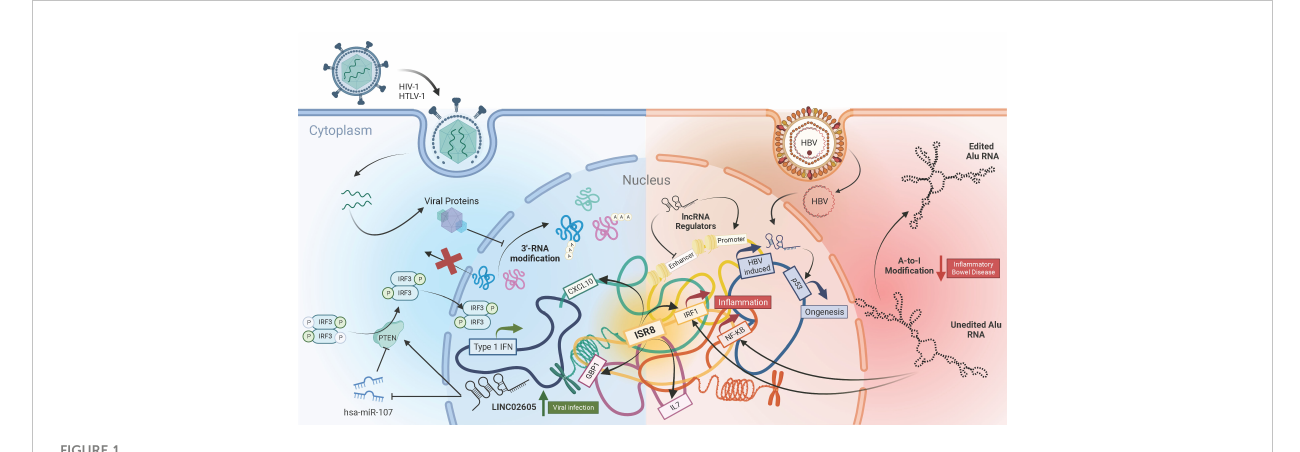
FIGURE 1 The complex landscape of lncRNAs in viral Infections and